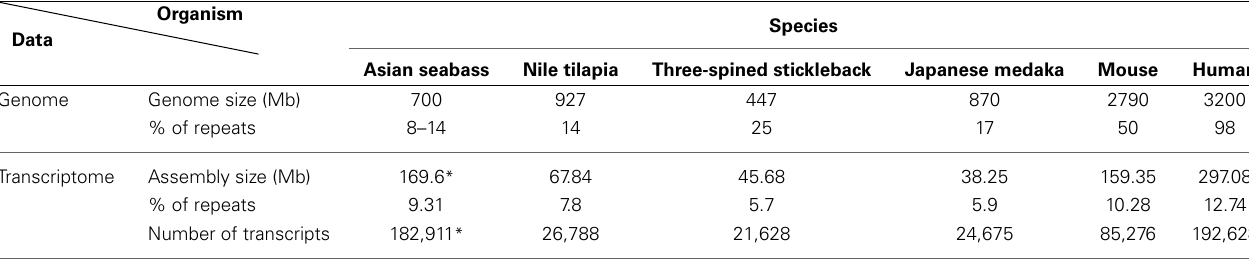
Table 2 | Comparative analysis of the repeat content of teleost and mammalian transcriptomes and genomes showed distinct differences between groups and among